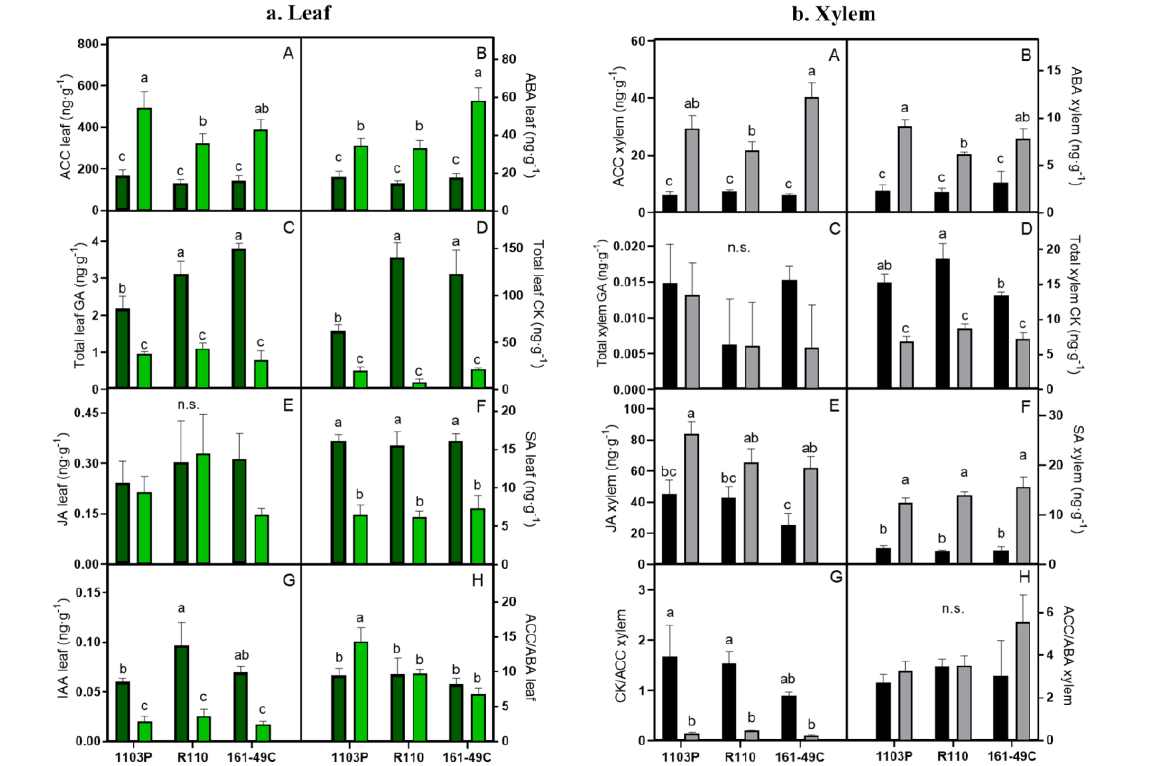
Figure 3. Leaf ( a ) and xylem ( b ) phytohormone concentrations under well water (WW) (dark green and black) and water stress (WS) (light green and grey) for the rootstocks studied. (A) Ethylene precursor 1-aminocyclopropane-1-carboxylic acid (ACC), (B) abscisic acid (ABA), (C) gibberellins (GA), (D) cytokinins (CK), (E) jasmonic acid (JA), (F) salicylic acid (SA), (G) indole-3-acetic acid (IAA) and (H) ACC/ABA ratio. Values represented are means ± SEM of each treatment and rootstocks. Different letters indicate statistically significant differences by one-way ANOVA with Duncan’s multiple comparison test ( p < 0.05), while n.s. shows non-significant differences.